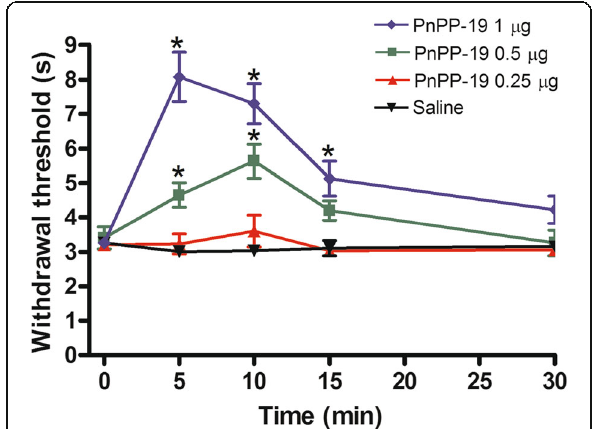
Fig. 1 Central antinociception induced by intracerebroventricular administration of PnPP-19 in mice. PnPP-19 (0.25, 0.5 and 1 μ g) was administered 5 min prior measurement in the tail-flick test. Each line represents the mean ± SEM for four mice per group. *Significant difference compared to the Saline-injected group (ANOVA+Bonferroni test, p <0.05). Saline (0.5% of Evans